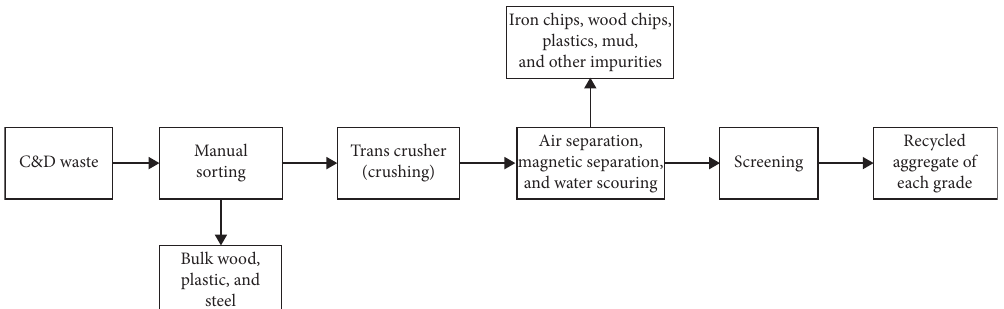
Figure 1: Production process of the RA.